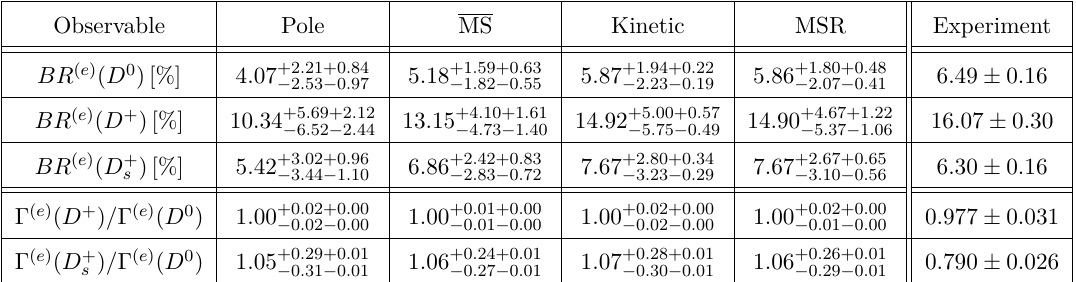
Table 11. Semileptonic decay widths in inclusive channel Xeν in units ps − 1 , and their ratios for charmed mesons compared to the experimental values, using HQET parameters. The first uncertainties are coming from independent variations of the hadronic matrix elements within the corresponding ranges, while the second uncertainties result from the variation of the renormalization scale µ in the range [1 , 3] GeV. The references to the sources of the experimental data are given in section